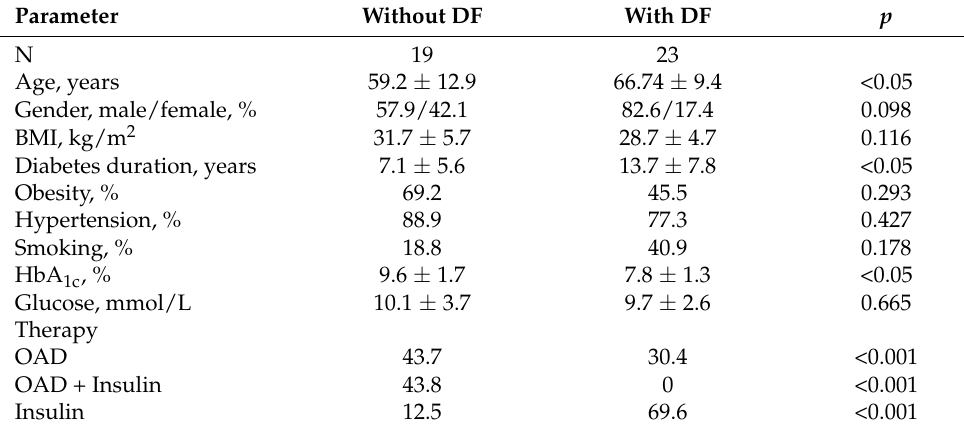
Table 1. Demographic and clinical data of study